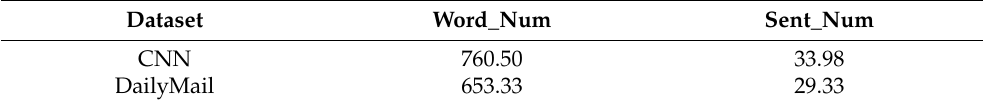
Table 5. Comparison of document length between CNN and DailyMail datasets, where “Word_num” and “Sent_num” denote the average number of words and sentences in the document, respectively.